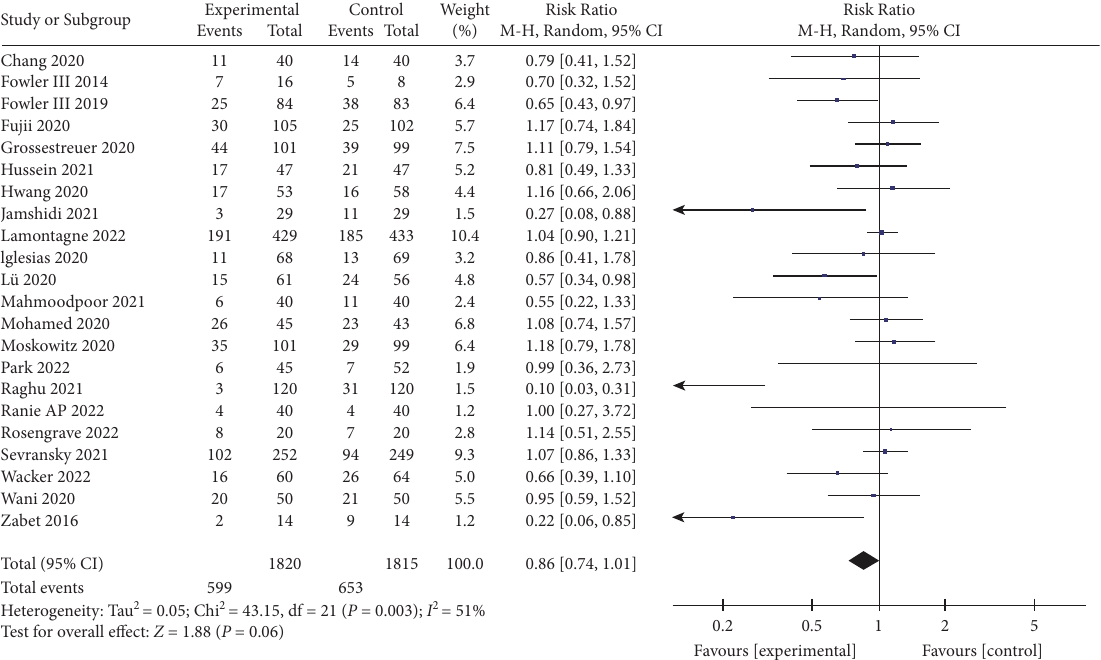
Figure 3: Forest plots for the efect of vitamin C on overall